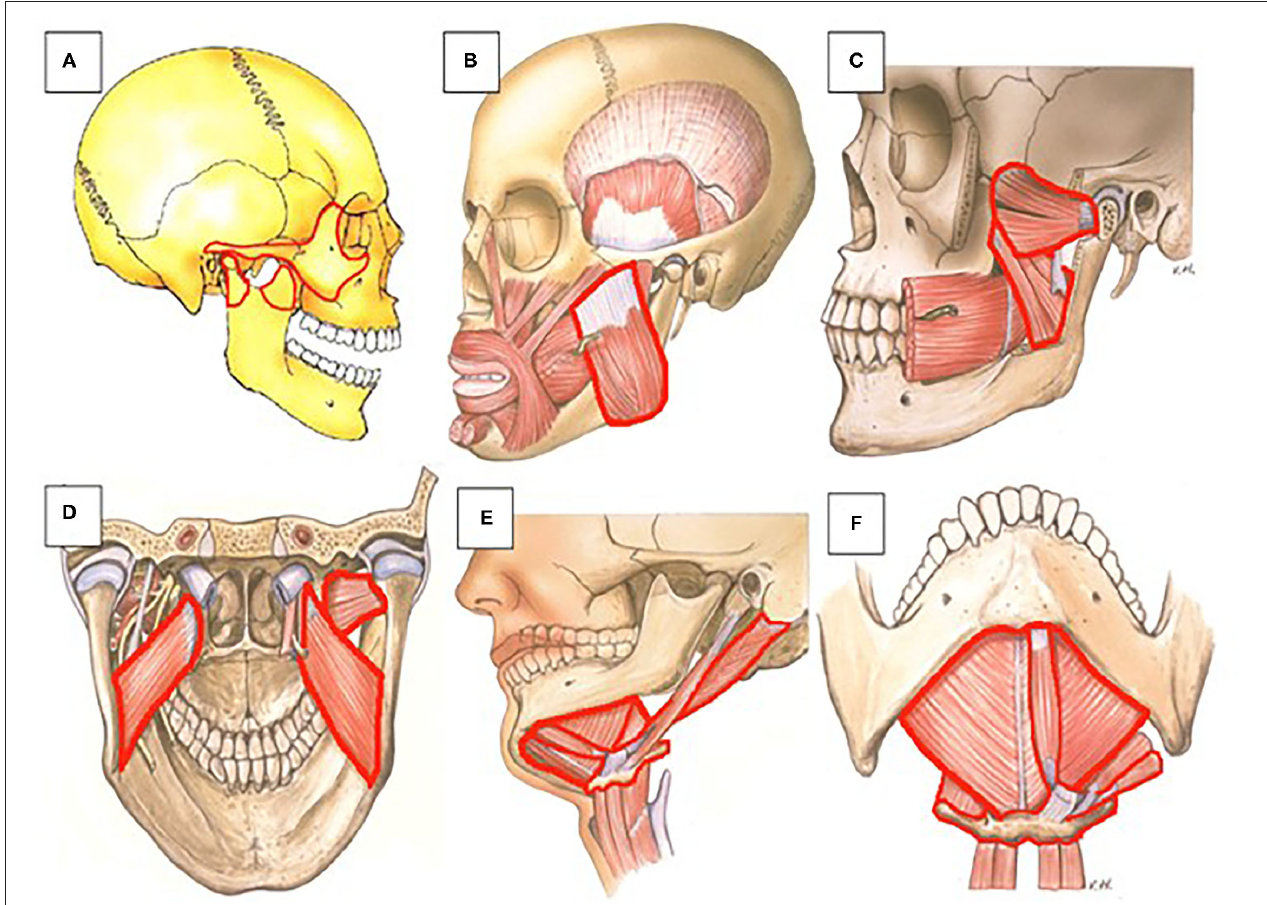
FIGURE 4 | Anatomic representation of maxillofacial structures and muscles that can be affected by HO in FOP patients. (A) (1) The coronoid process (front side of the rami) can ossify with the zygomatic arch. (2) The coronoid process and zygomatic arch can ossify individually. (3) The condyle process (back side of the rami) can ossify individually (lateral view). (B) The masseter (lateral view). (C) The lateral and medial pterygoid (lateral view). (D) The lateral and medial pterygoid (posterior view). (E) The suprahyoid muscles (digastric, geniohyoid, and mylohyoid) can ossify with the hyoid bone (lateral view). (F) The suprahyoid muscles (digastric, geniohyoid, and mylohyoid) can ossify with the hyoid bone (inferior view). Frequencies of HO of the various muscles and bony regions are shown in Figure 5 . Picture: Courtesy of Jan Harm Koolstra, ACTA, The